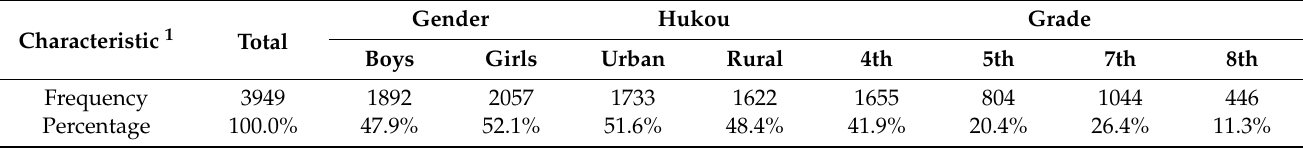
Table 1. Sample distribution according to selected personal